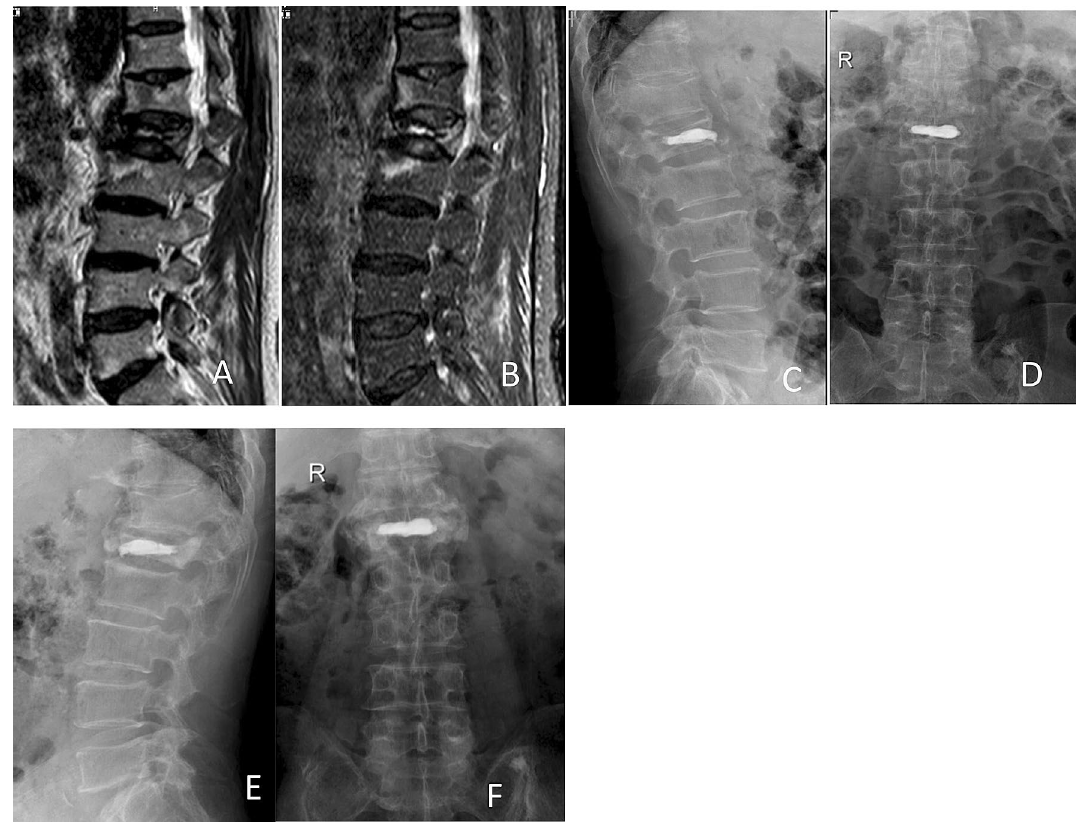
Figure 1. Preoperative and postoperative films of a 65-year-old woman with OVCFs of L1 vertebral body, treated with high-viscosity cement PVP. Preoperative sagittal MR image showing significant loss of the anterior vertebral body height at the L1 level ( A ), ( B ). Anterior–posterior and lateral films showing no leakage of bone cement postoperatively ( C ), ( D ) and at 1 year postoperatively ( E ), ( F